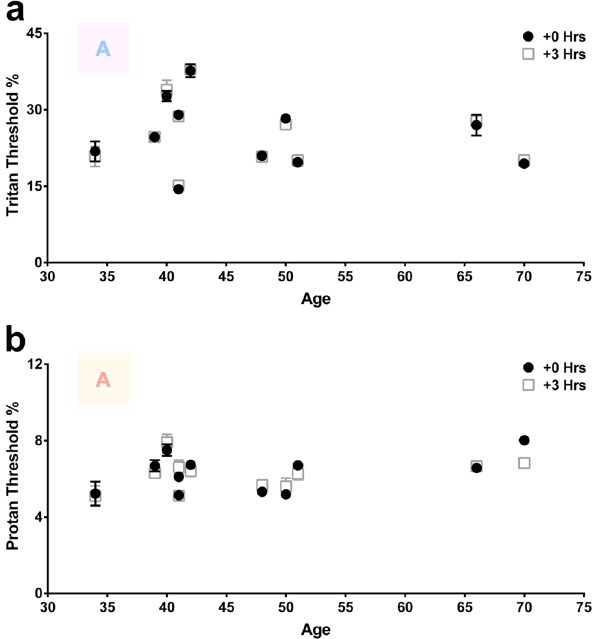
Figure 2. Colour contrast sensitivities (CCS) from a control cohort measured at the same time of day (8-9AM) with no 670 nm light exposure. CCS of tritan ( a ) and protan ( b ) axes measured in 10 subjects (34–70 years) at 8-9AM and 3 h later in the same manner as morning 670 nm light exposure and re-testing. Black closed circles represent measurements taken at 8-9AM to mimic baseline measures and time of 670 nm light exposure. Grey open boxes are those in the same individuals measured 3 h later between 11AM-12PM to mimic the time interval a perceived effect to 670 nm light exposure was achieved. The colour letter A in both graphs is an example of the target to be identified as it appeared on the screen. Thresholds for tritan function revealed no significant difference (p = 0.4648) when measured 3 h apart, simulating the same time of day for morning 670 nm light exposures. Similarly, thresholds for protan function revealed no significant difference (p = 0.9658) across all 10 subjects. Wilcoxon matched-pairs signed rank test was used for statistical analysis. Data are presented as means ±